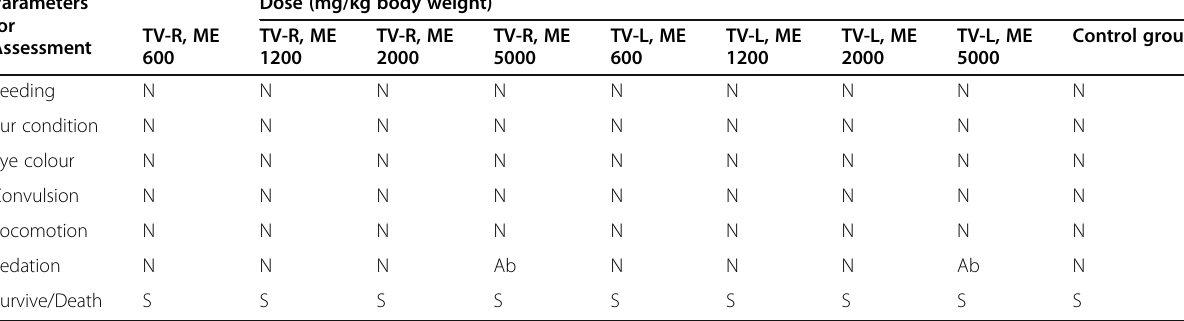
Table 1 Assessments during lethality (LD 50 ) test, recorded observations for 1 – 72 h Parameters for Assessment